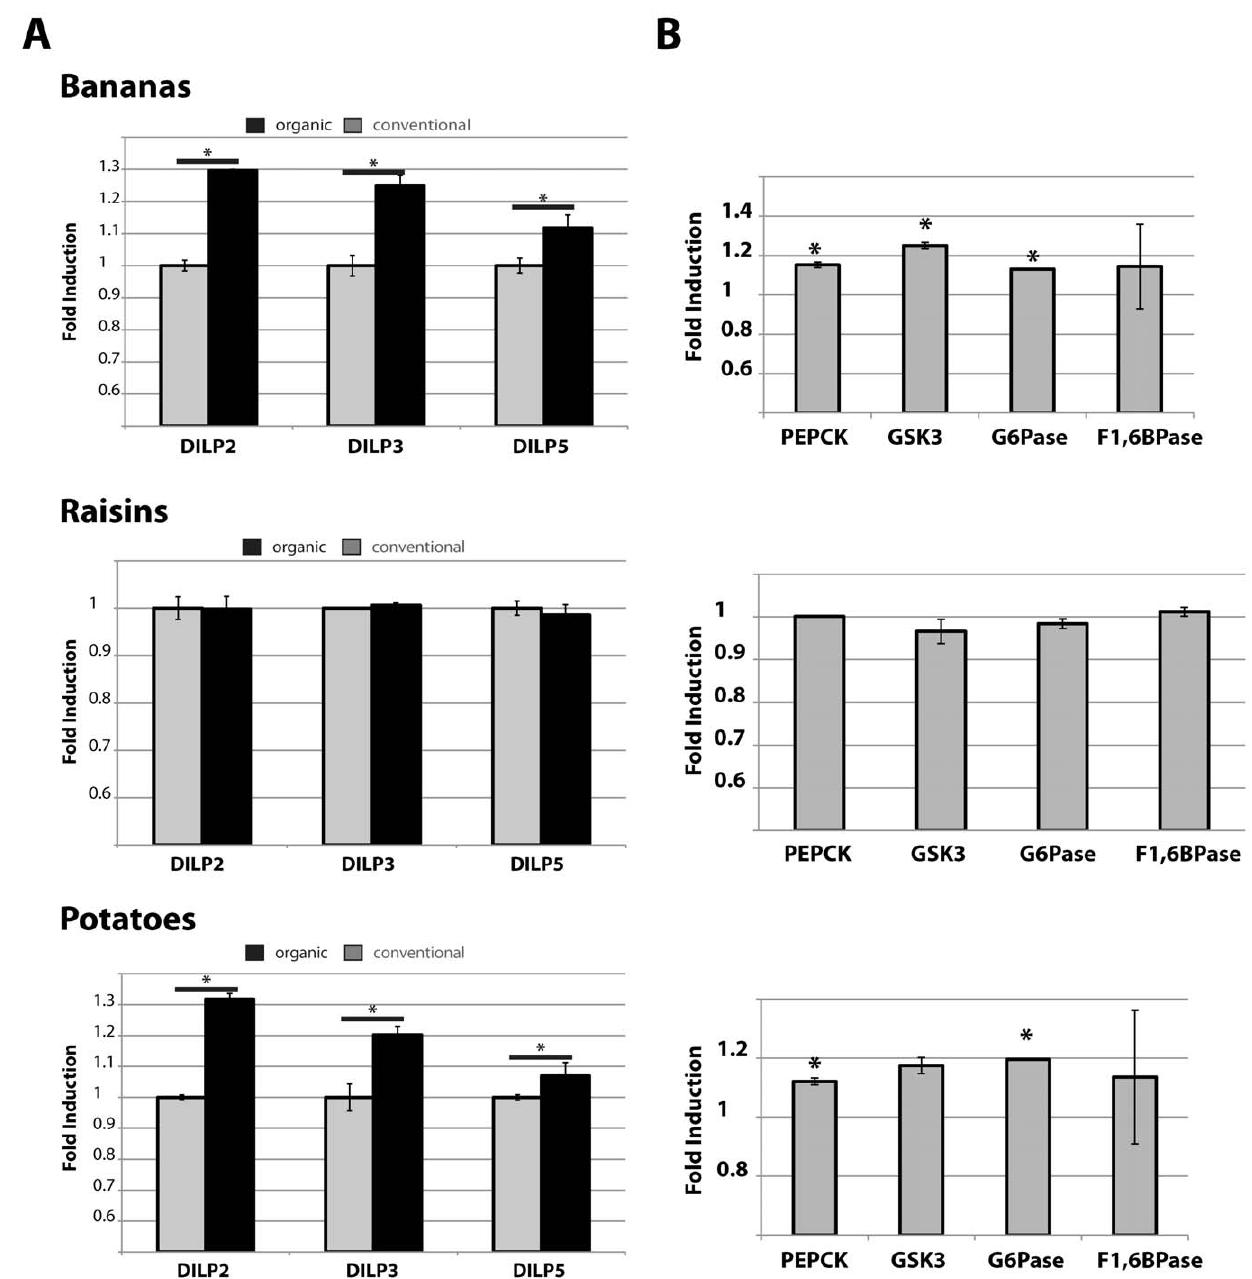
Figure 5. QPCR analysis of fruit flies raised on organic diets. Flies were raised for ten days on the indicated diets and mRNA was isolated from whole body extracts of females. Levels are shown as fold-induction compared to the mRNA levels of flies raised on conventional diets (A) Levels of the indicated DILP mRNAs were normalized against beta-tubulin (shown are the averages of five biological replicates; error bars represent the standard deviation; statistically significant changes (p , 0.005) are indicated by asterisks; grey: conventional food; black: organic food). (B) mRNA levels of the indicated metabolic genes were normalized against rp49 (shown are the averages of two experiments; error bars represent the standard deviation; statistically significant changes (p , 0.05) are indicated by